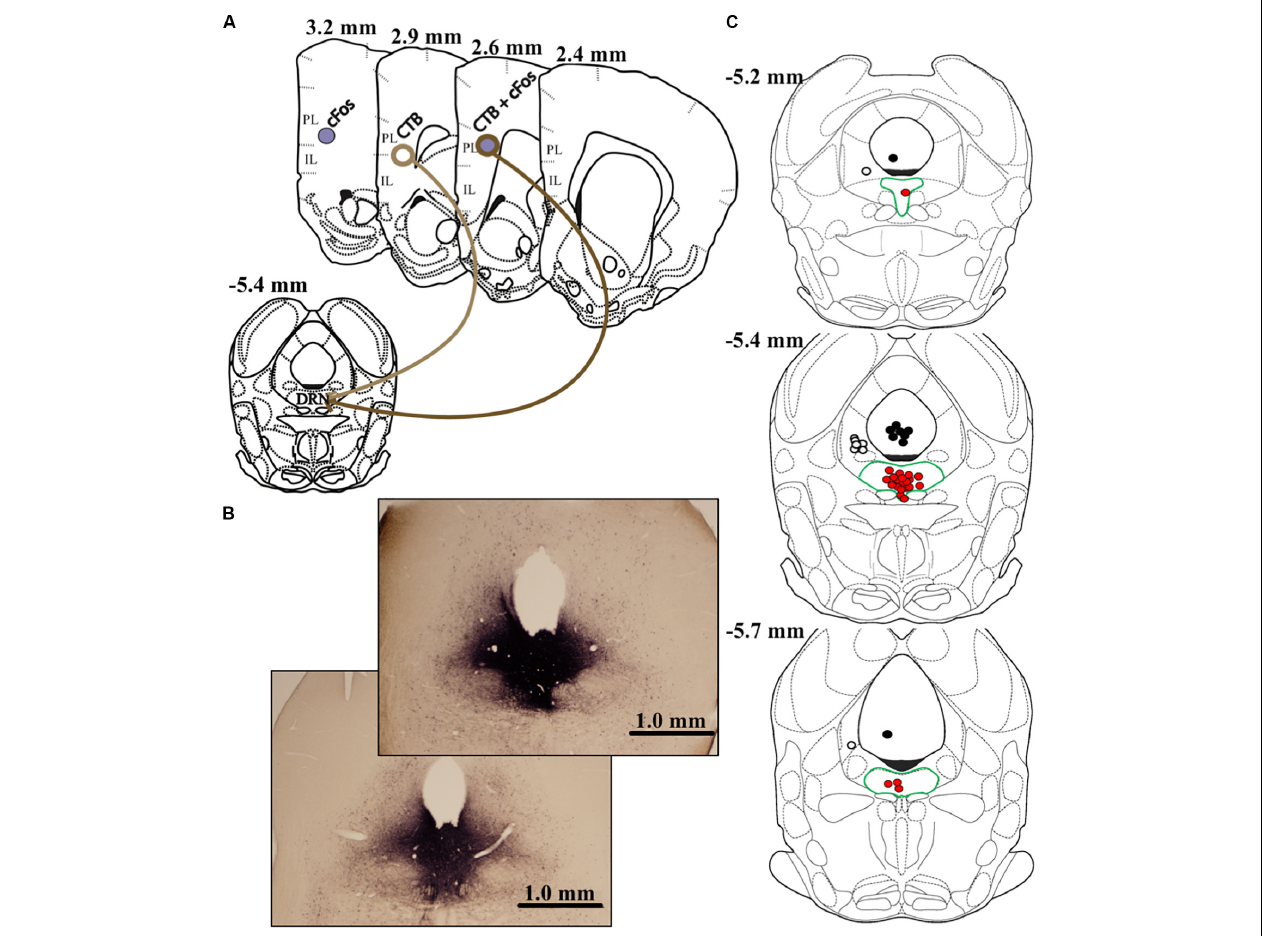
FIGURE 2 | The graphic in (A) depicts the anatomical locations of CTB injection within dorsal raphe (DRN) and prelimbic (PL) or infralimbic (IL) subregions of vmPFC where data were quantified. Differential appearances of cFos, CTB, and cFos + CTB IR afforded by immunohistochemical procedures are also shown. cFos+ cells present as purple, solid, nuclear staining due to nickel enhancement. On the other hand, CTB+ cells appear as brown, opened staining of neuronal membranes. Dual-labeled cells, characterized by brown membranous staining around purple nuclei, indicate a DRN-projecting neuron that was activated by acute social defeat stress. Representative images of DRN injections (25 nl CTB) are shown in (B) . Importantly, nickel-enhanced staining was conducted to maximize contrast when verifying injection placement and CTB diffusion. Thus, CTB IR in (B) differs in appearance than elsewhere in this report. Notably, the top image (subordinate) represents the maximum-acceptable spread of CTB, whereas the bottom image (dominant) represents average diffusion. The graphic in (C) depicts all estimated injection points, some overlapping, within the DRN. Red dots depict DRN-targeted injections, and DRN is highlighted by green borders. To control for diffusions beyond DRN boundaries, injections targeting the left ventral periaqueductal gray (lvPAG) and 4th ventricle are depicted as white or black dots, respectively. Measurements on atlas templates refer to distance from bregma according to Morin and Wood